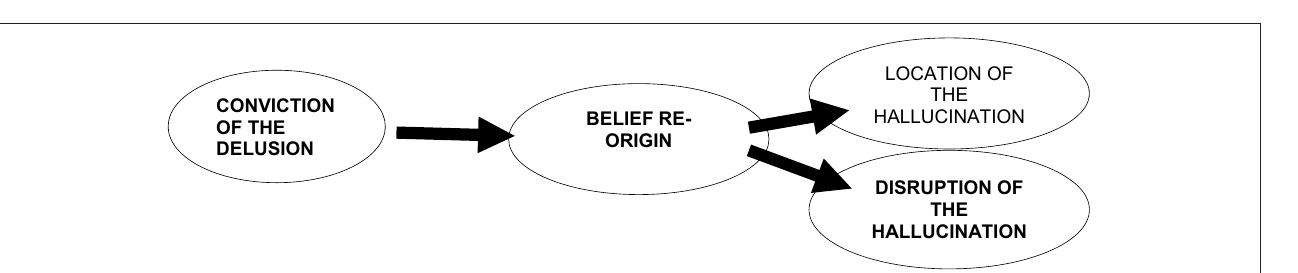
Frontiers in Psychology |